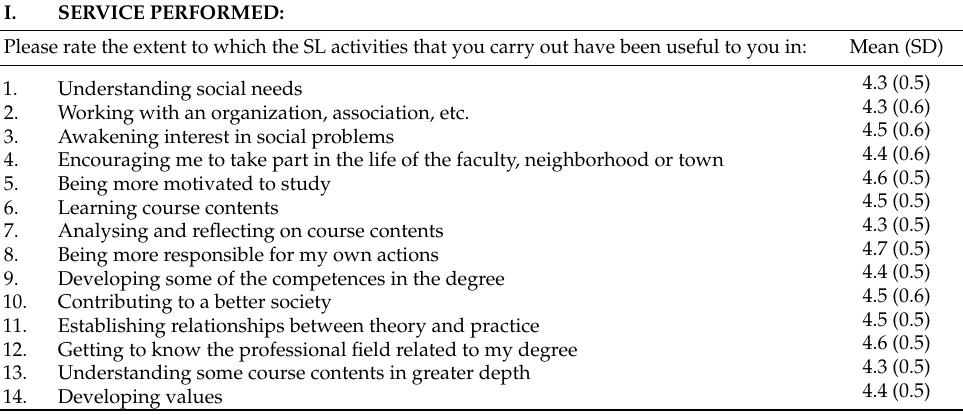
Table 3. Results of the overall service-learning performed (Service-Learning Questionnaire) for the Service-Learning